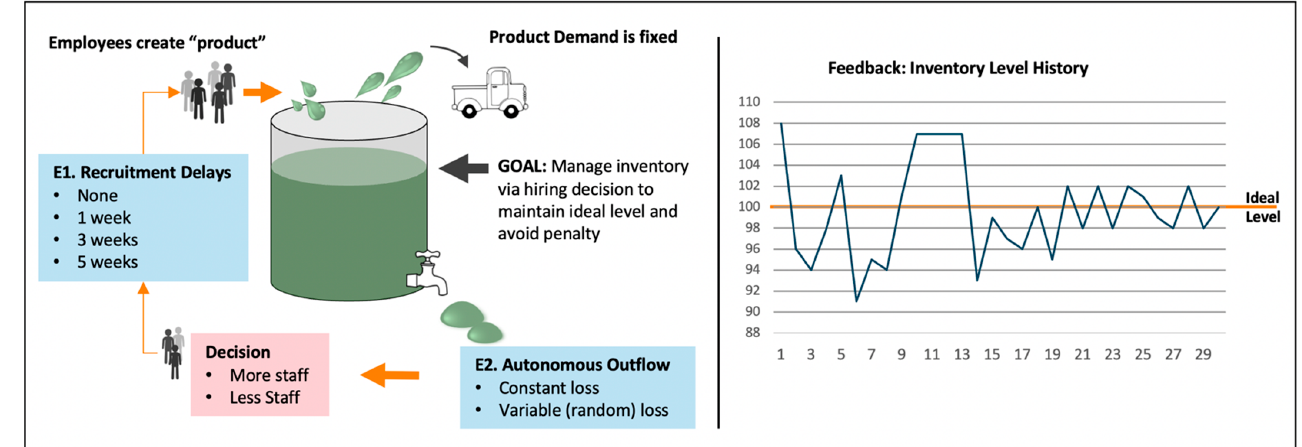
Figure 3. Schematic representation of microworld task described by Birney et al. (2018) and experi- mental manipulations (E1 and E2) with exemplar trial-by-trial inventory level feedback across 30 decision periods (which defined a single “attempt”).